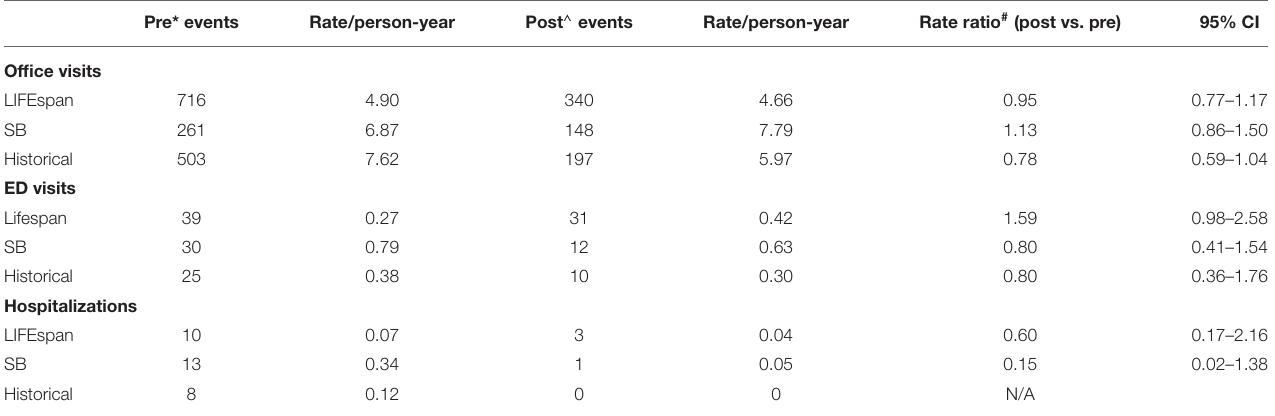
TABLE 2 | Secondary outcomes: physician office visits, emergency department (ED) visits, and hospitalizations by study